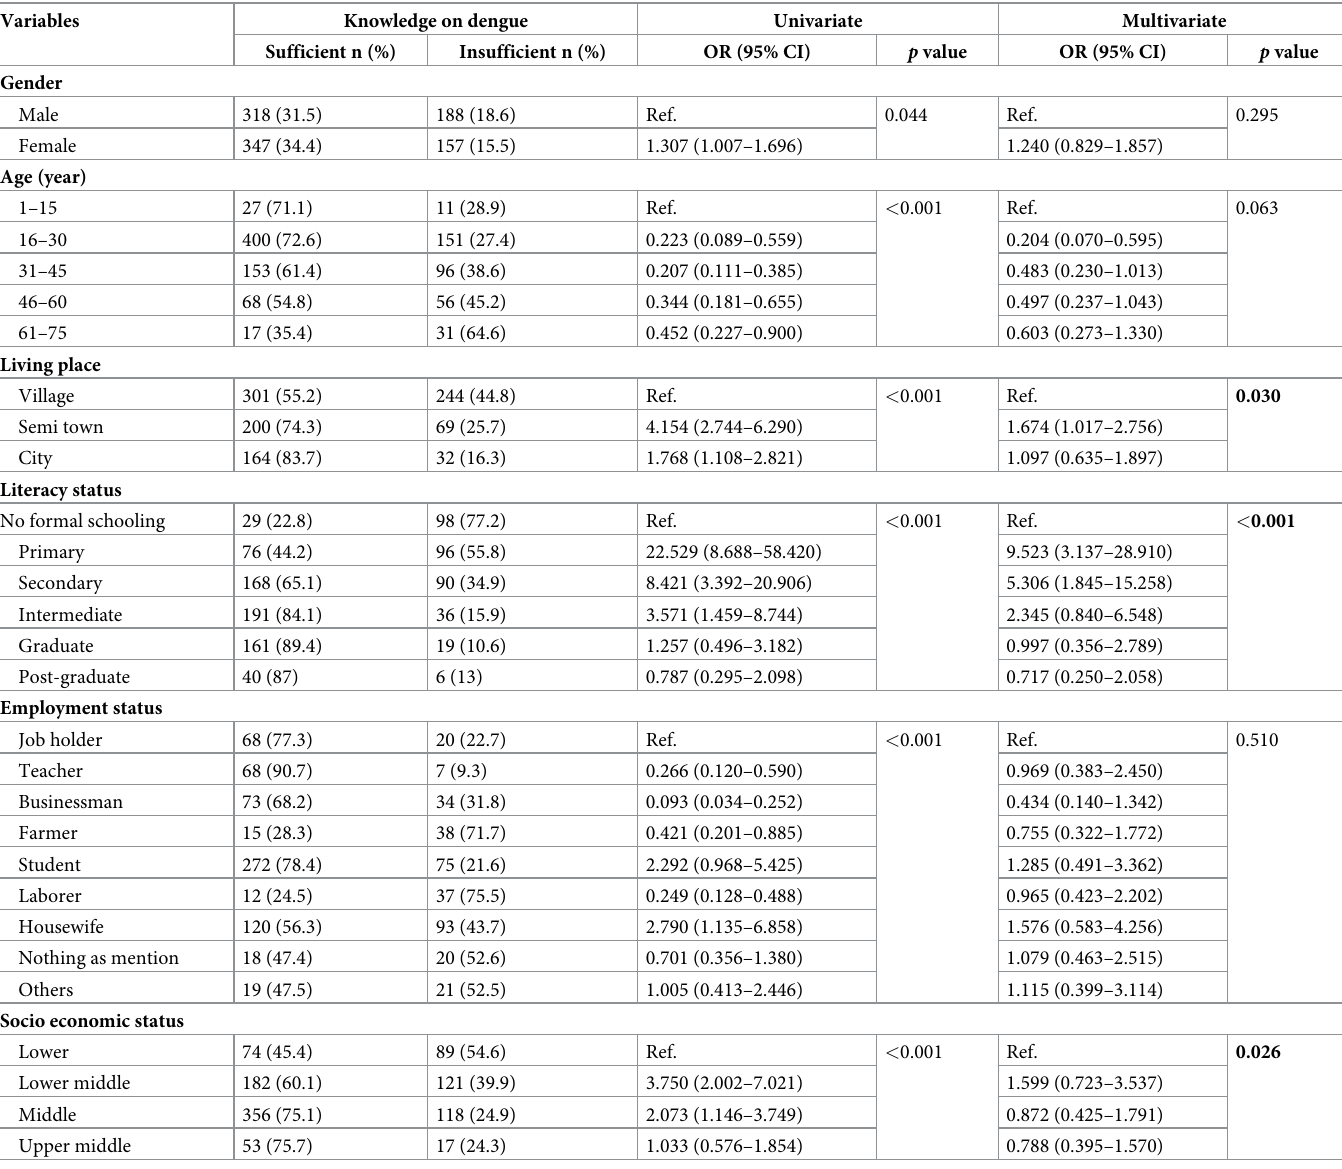
Table 4. Univariate and multivariable analyses of factors associated with knowledge of dengue (n =